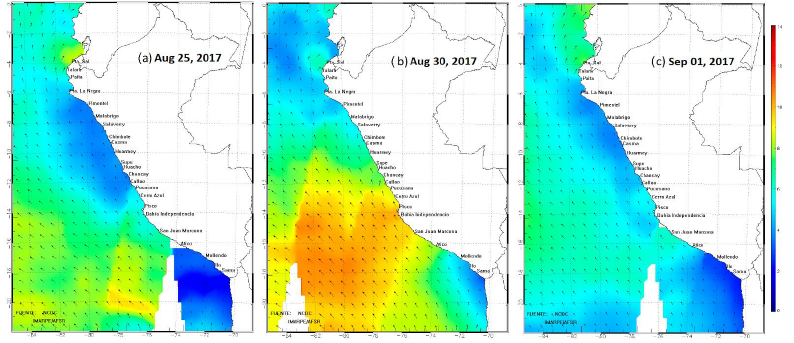
Figure 4. Wind speed satellite images (m s − 1 ) ( a ) 25 August 2017; ( b ) 30 August 2017; ( c ) 1 September 2017. 3.1.3. Sea Surface Temperature (SST) Surface temperatures in the southern exterior of Paracas Bay on 25 August were around 16.5 °C, presenting colder waters (<16 °C) until 1 September. By contrast, surface temperatures in Paracas Bay and the northern sector were 17.5 °C on 25 August, which rose to 19.5 °C on 29 August and 1 September (Figure 5a – c).